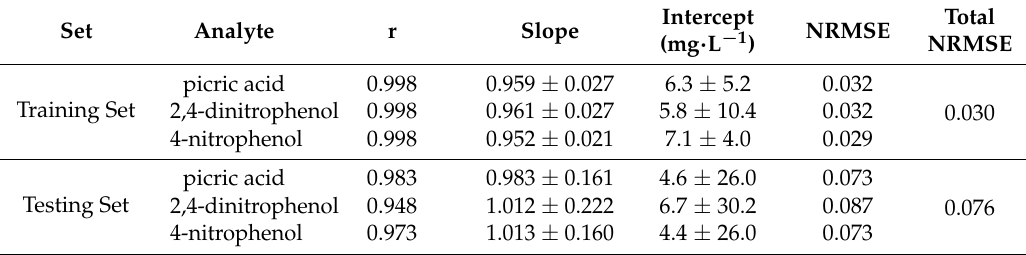
Figure 7. Obtained vs. expected concentrations plots for the training set (black points and dashed line) and the testing set (white points and solid line) for ( A ) picric acid; ( B ) 2,4-dinitrophenol; and ( C ) 4-nitrophenol. Table 1. Results of the fitted regression curves for obtained vs. expected values, for the training and testing subsets of samples and the three considered nitrophenols (intervals calculated at the 95% confidence level).